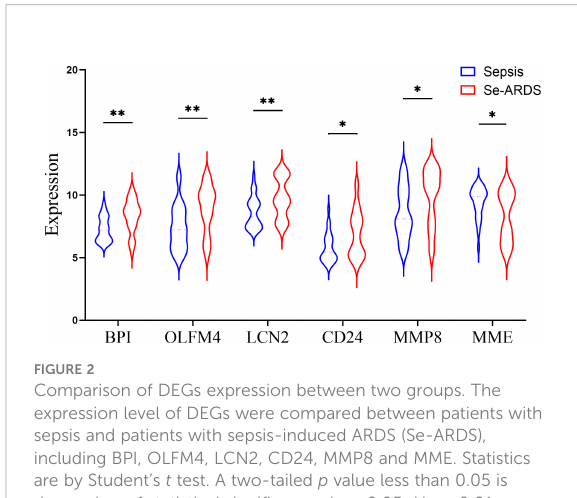
FIGURE 2 Comparison of DEGs expression between two groups. The expression level of DEGs were compared between patients with sepsis and patients with sepsis-induced ARDS (Se-ARDS), including BPI, OLFM4, LCN2, CD24, MMP8 and MME. Statistics are by Student ’ s t test. A two-tailed p value less than 0.05 is